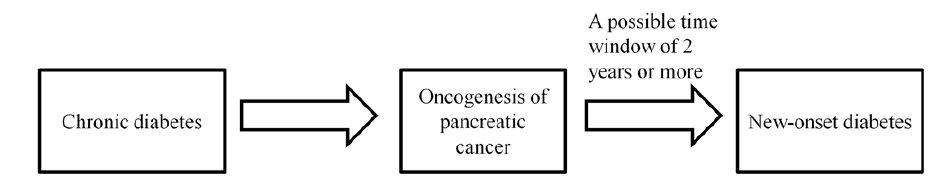
Figure 2. Diabetes can be both a cause and a consequence of pancreatic cancer.